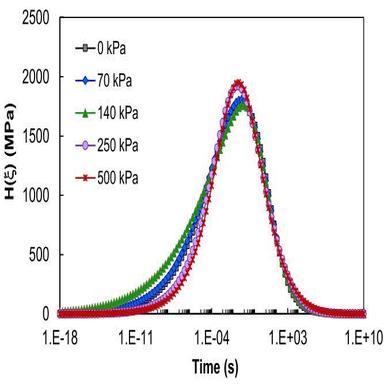
Continuous relaxation spectra at different confining pressures (Mix A).